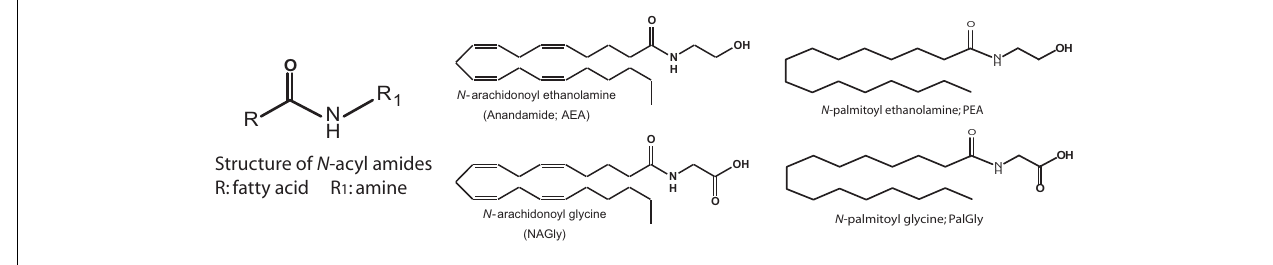
FIGURE 1 | Structure of N -acyl amides. N -acyl amides studied here have a structure that consists of an acyl group (denoted as R) and an amide bond to an amine (denoted as R 1 ) and this is depicted as a cartoon structure here (far left). 4 examples of N -acyl amide bioactive molecules are also depicted: